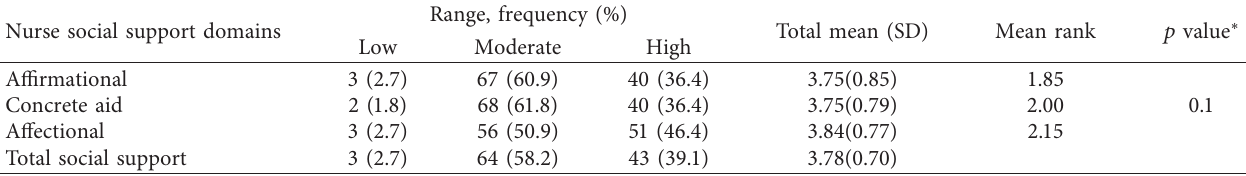
Table 2: The amount of mothers’ perception of social support provided by nurses in different supportive domains ( n � 110). Nurse social support domains